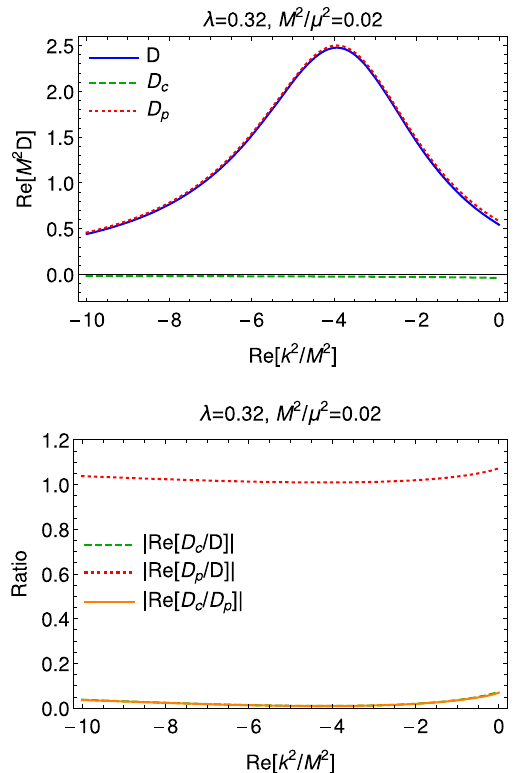
Fig. 24 The same plots for the gluon propagator in the Euclidean region as those in Fig. 18 for the choice of parameters with a smaller mass, λ = 0 . 32, M 2 /μ 2 = 0 . 02